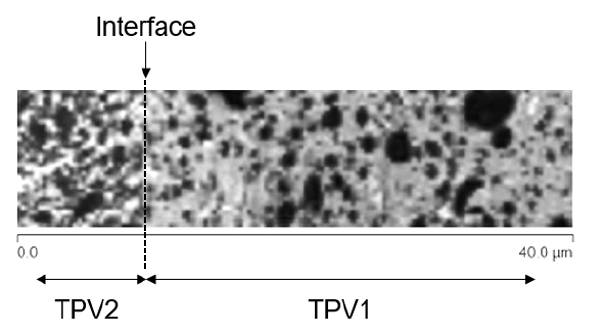
Figure 21. AFM phase image: TPV1-TPV2 interface observation by